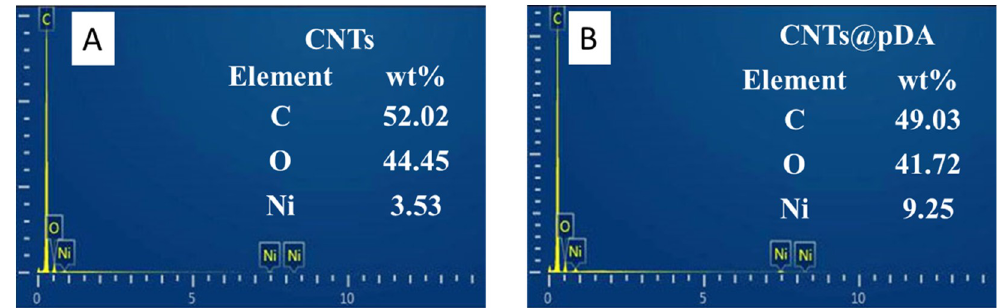
Figure 5. Image of the energy disperse spectroscopy (EDS) test of CNTs and CNTs@pDA dispersed in the electroplating bath for 24 h. After dispersed in the electroplating bath for 24 h, the mass fraction of Ni in CNTs@pDA ( B ) was higher than that of the original CNTs ( A ).